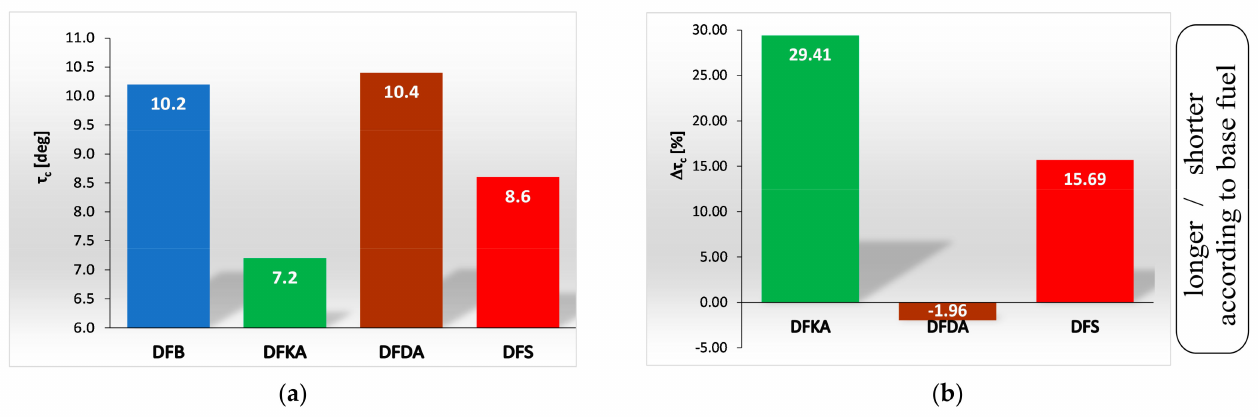
Figure 15. ( a ) Self-ignition delay ( τ c ) for tested fuels. ( b ) Percent change in self-ignition delay ( ∆ τ c ) for tested fuels relative to τ c for base